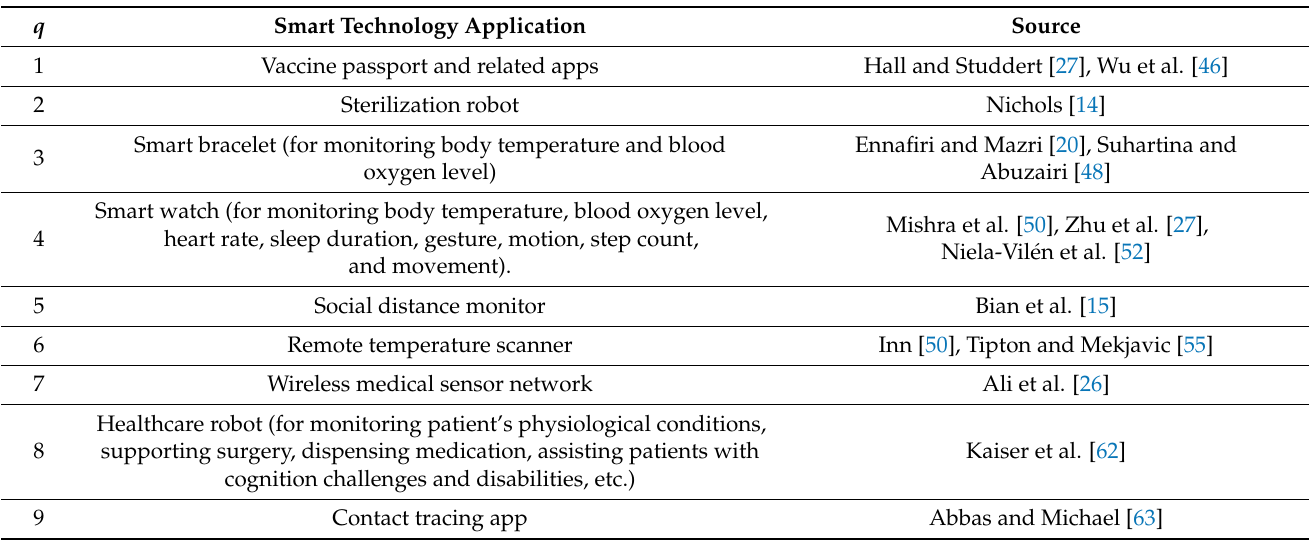
Wireless medical sensor network Healthcare robot (for monitoring patient’s physiological conditions, supporting surgery, dispensing medication, assisting patients with cognition challenges and disabilities,